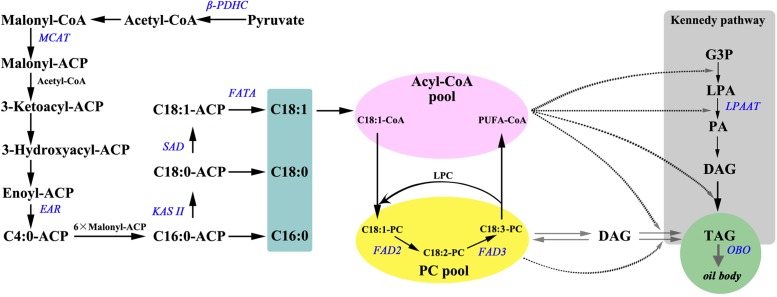
An overview of (A) major genes involved in fatty acid synthesis and triacylglycerol assembly. Substrates are in bold: ACP, acyl carrier protein; DAG, diacylglycerol; G3P, glycerol-3-phosphate; LPA, lyso-phosphatidic acid; LPC, lyso-phosphatidylcholine; PA, phosphatidic acid; PC, phosphatidylcholine; PUFA, polyunsaturated fatty acids; TAG, triacylglycerol. Enzymatic reactions are in bold italics: β-PDHC, pyruvate dehydrogenase beta subunit; MCAAT, malonyl-CoA:ACP transacylase; EAR, enoyl-ACP reductase; KAS II, ketoacyl-ACP synthase II; SAD, stearoyl-ACP desaturase; FAD3, Δ15 (ω-3) linoleic acid desaturase; FATA, acyl-ACP thioesterase A; FAD2, Δ12 oleic acid desaturase; LPAAT, 1-acylglycerol-3-phosphateacyltransferase; OBO, oil-body oleosin.